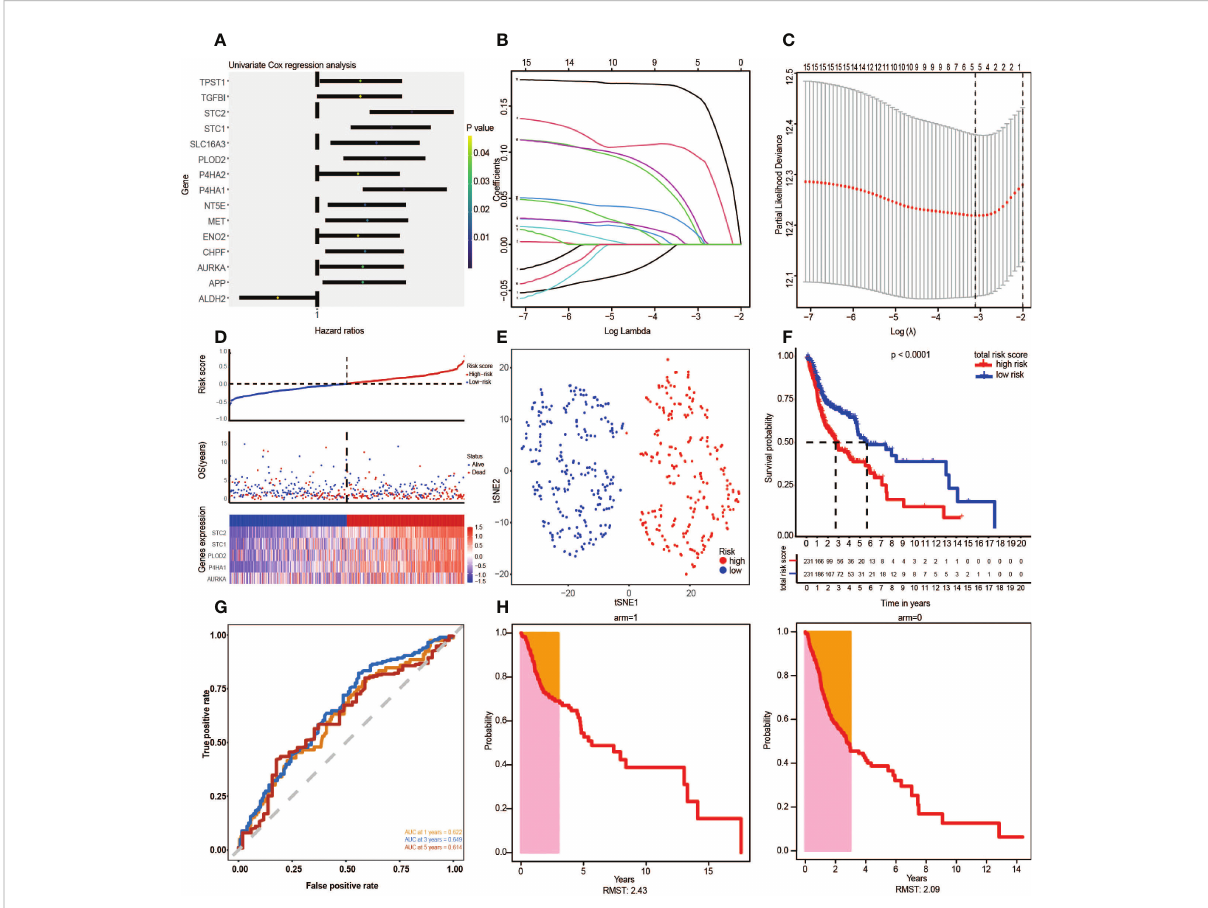
FIGURE 3 The Glycolysis-Related Gene Signature on the training cohort was constructed to predict patient outcomes. (A) Univariate Cox regression analysis yielded 15 prognosis-associated differentially expressed glycolysis-related genes. (B, C) LASSO regression analysis identi fi ed the fi ve prognostic genes. (D) The TCGA risk score, survival time, survival status, and expression of the fi ve-gene signature. (E) t-SNE cluster showed groups with high and low-risk scores. (F) Kaplan-Meier survival curve analysis for HNSCC patients divided into high-risk and low-risk groups. (G) Time-independent ROC curve of a risk score for prediction of 1-year, 3-year, and 5-year overall survival outcomes. (H) RMST plot for the TCGA training